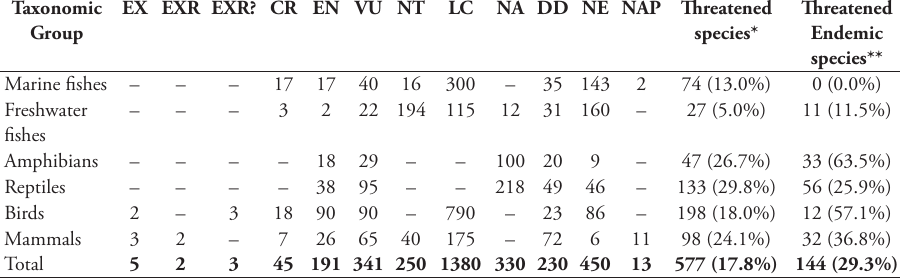
Table 3. Number of species in each conservation status category and total numbers and percentages of threatened and threatened endemic species (EX, Extinct; EXR, Regionally Extinct; CR, Critically Endangered; EN, Endangered; VU, Vulnerable; NT, Near Threatened; LC, Least Concern; NA, Not Threatened; DD, Data Deficient; NE, Not Evaluated; NAP, Not Applicable; “?”, possible). *CR, EN, VU, percentages are calculated over the total of native species of the group. ** Percentages are calculated over the total of endemic species of the